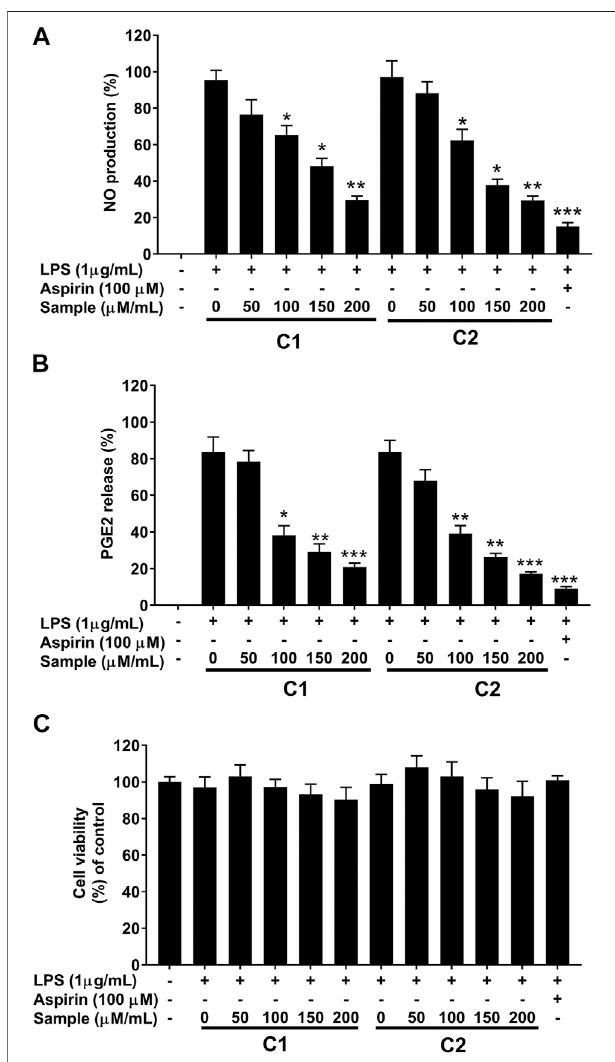
FIGURE 7 | Effects of puri fi ed compounds on production of nitric oxide and prostaglandin E2 and cytotoxicity in RAW 264.7 cells. Cells (1.0 × 105 cells/ml) were stimulated by LPS (1 μ g/ml) for 24 h in the presence of compounds (50, 100, 150, and 200 µ/ml). Culture media were collected in order to measure (A) NO and (B) PGE2 production by the Griess reaction andELISAassay,respectively. (C) CytotoxicitywasdeterminedusingtheMTT method. Values are the mean ± standard error of triplicate experiments. * p < 0.05, ** p < 0.01 and ** p < 0.001 for the comparison with the LPS- stimulated